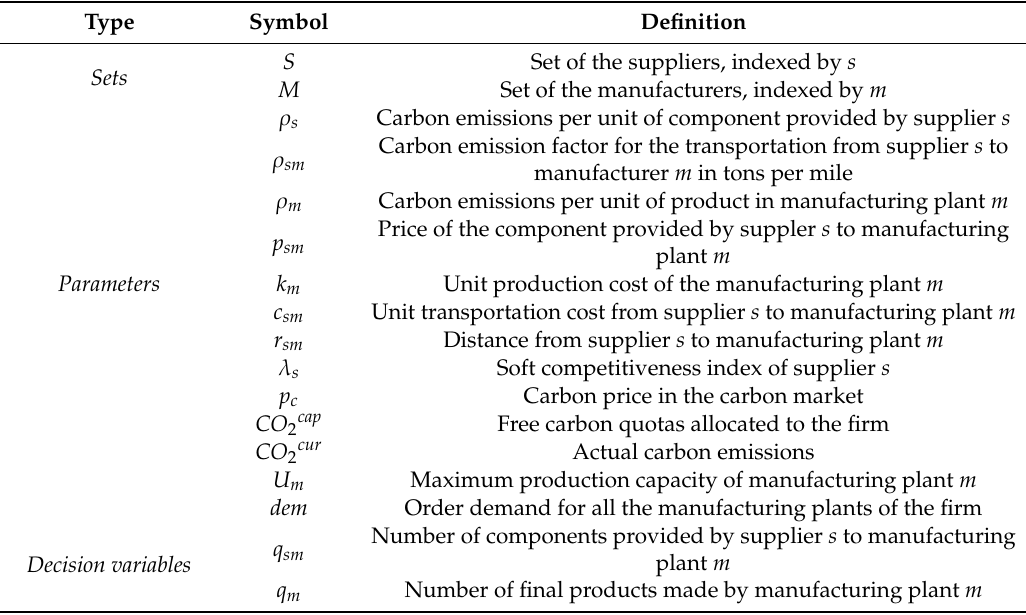
Table 3. Symbols and definitions of the parameters and